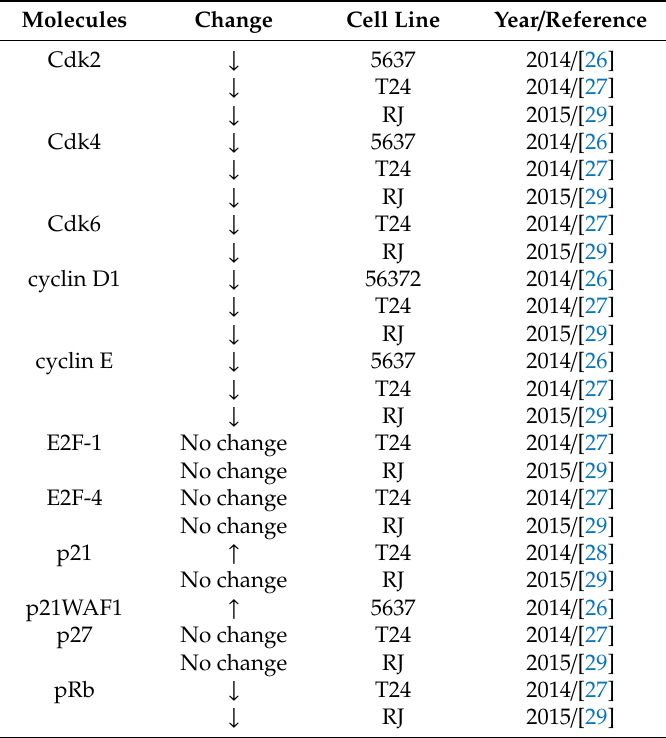
Table 3. Fucoidan-induced changed of cell-cycle-related